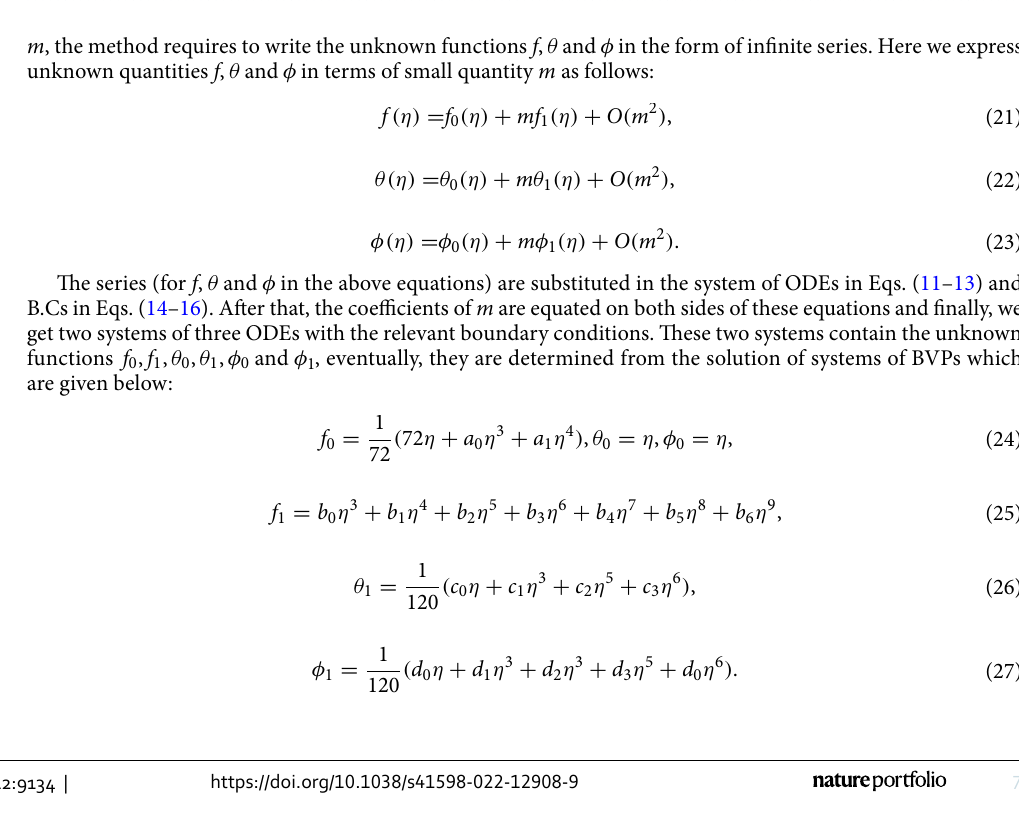
Figure 4. The dimensionless pressure at wall i.e. P (1) is plotted against solutal Grashof numbers Gr S , whereas, flow of air is taken in ( a ) converging and ( b ) diverging